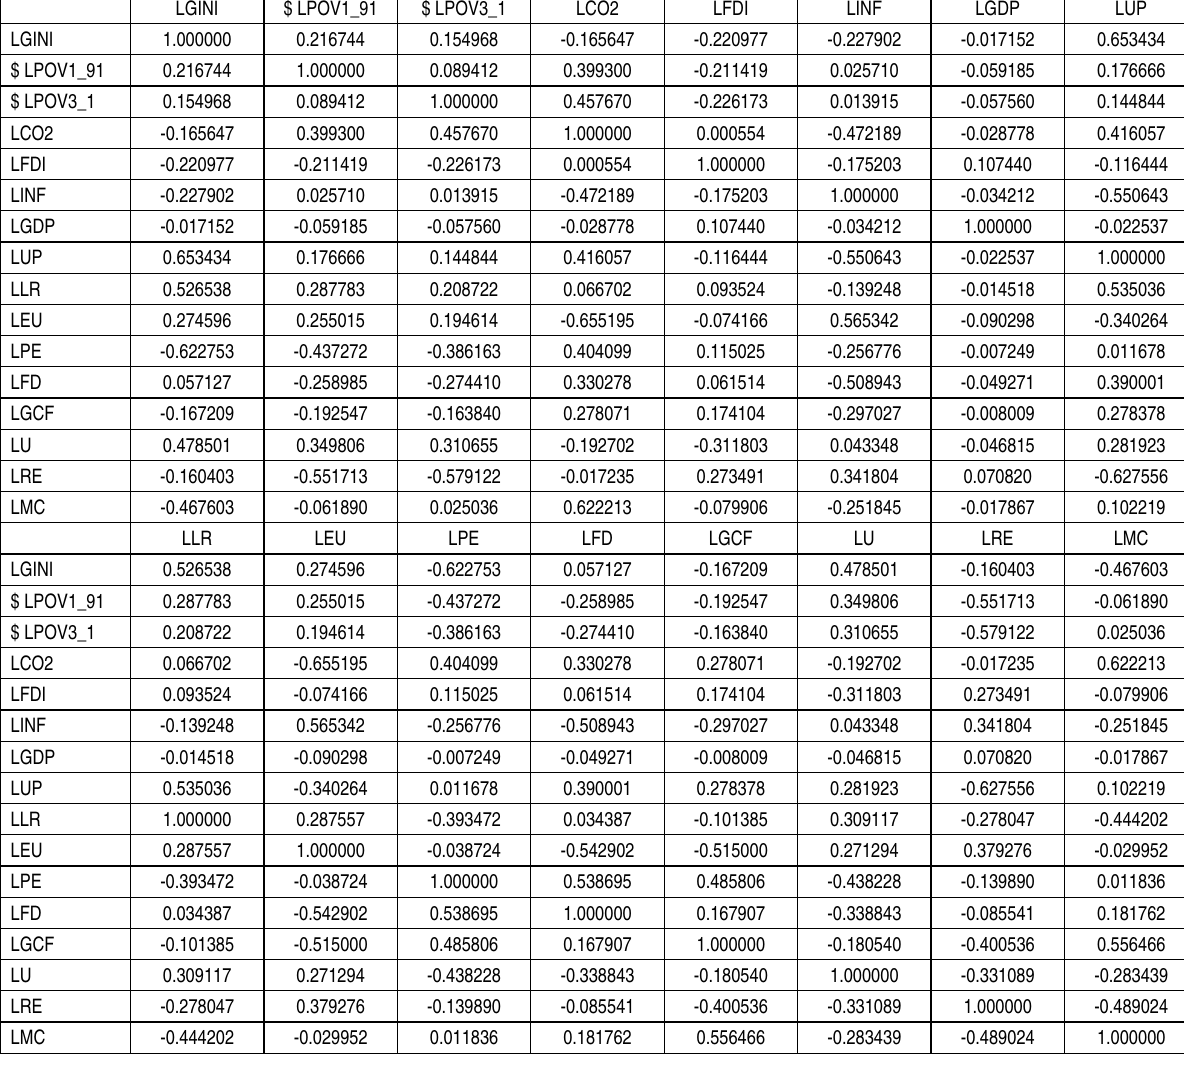
Table 5. The unit root